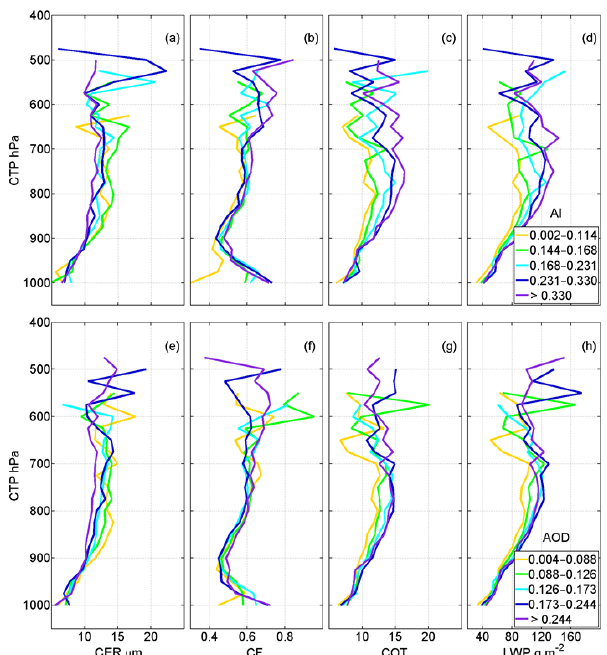
Figure 4. Cloud properties, 10-year averaged, as a function of cloud-top pressure: CER (a, e) , CF (b, f) , COT (c, g) and LWP (d, h) as functions of cloud-top pressure (CTP) for five classes of AI (a– d) and AOD (e–h) . Each class of AI–AOD contains an equal num- ber of samples in that